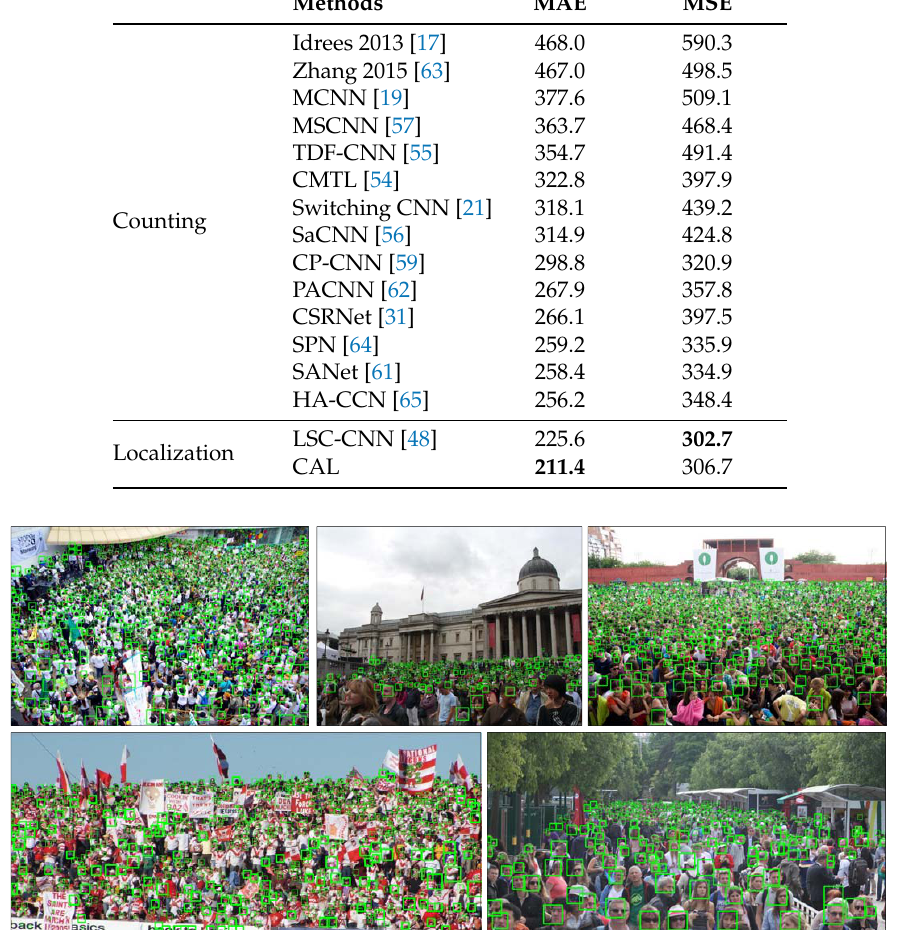
Figure 3. Qualitative results on the ShanghaiTech Part A.